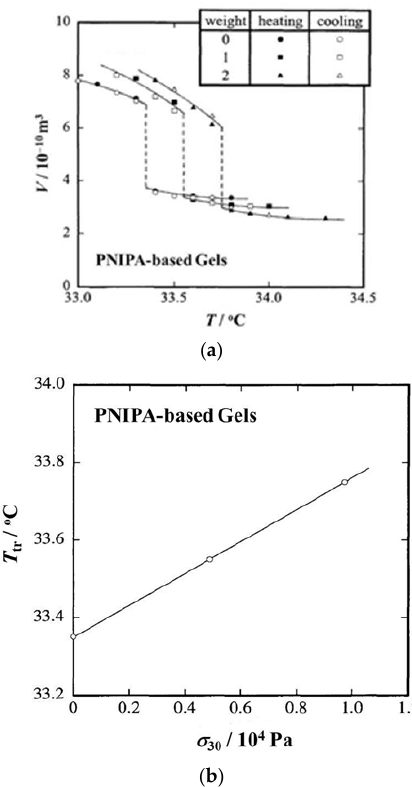
Figure 7. ( a ) Temperature dependence of gel volume and ( b ) stress dependence of transition temperature for PNIPA based gel [12]. Here, σ 30 stands for the true stress at 30 ◦ Table 1. Force in the number of metal weight ( f ), transition temperature ( T tr ), volume change of gel specimen per unit mass of polymer network ( V ) and transition enthalpy per unit mass of polymer network ( H ).